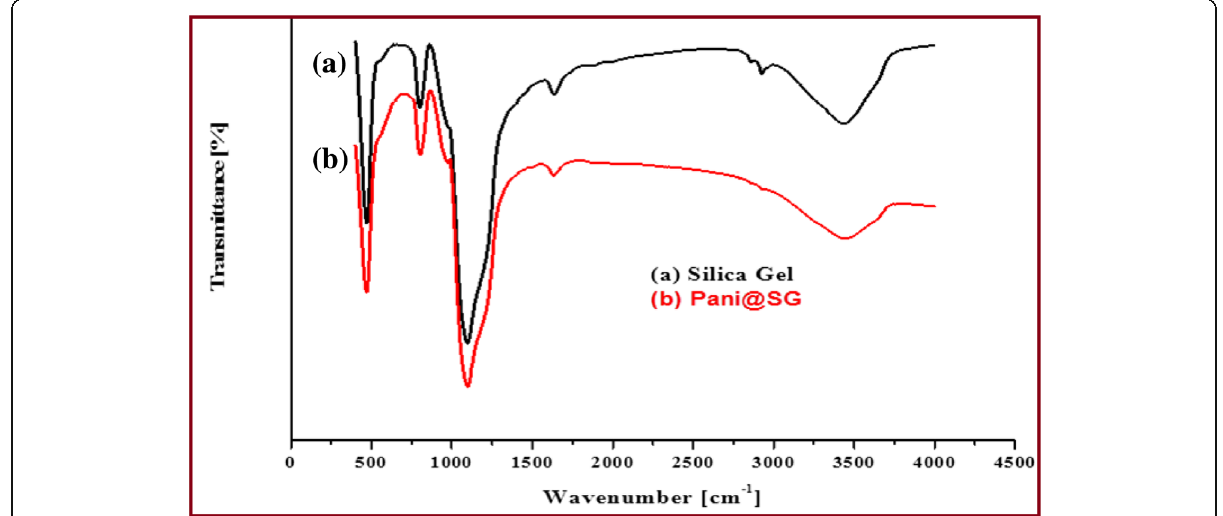
Fig. 1 FTIR spectra of (a) silica gel (S 1 ) and (b) Pani@SG (ES)-S 2